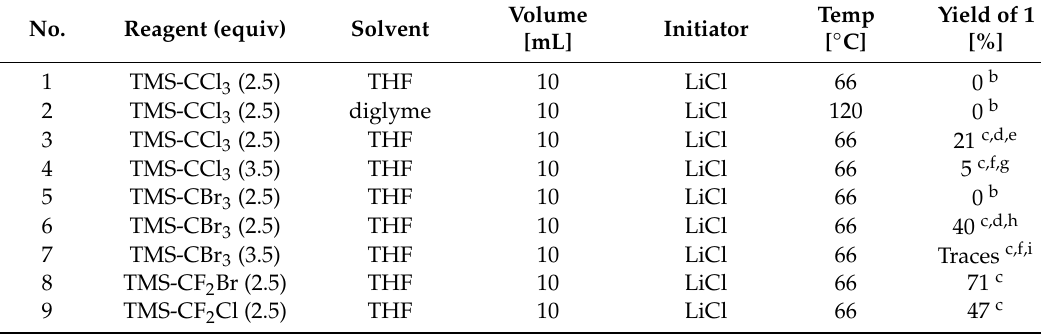
Table 5. Other dihalocarbene sources a